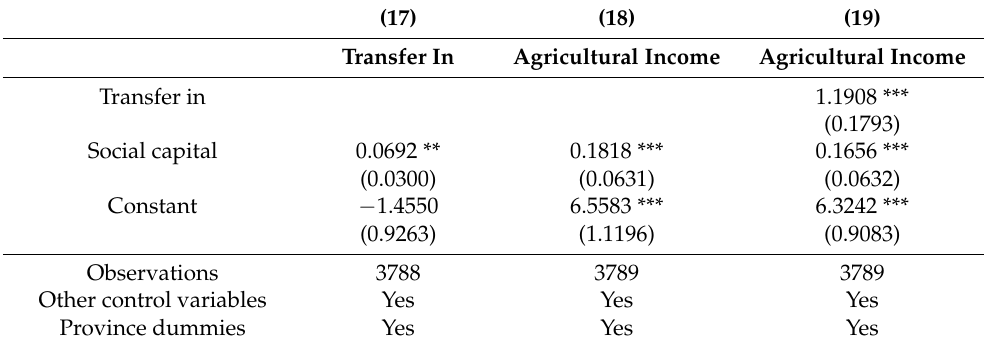
Table 5. Intermediating effect test.